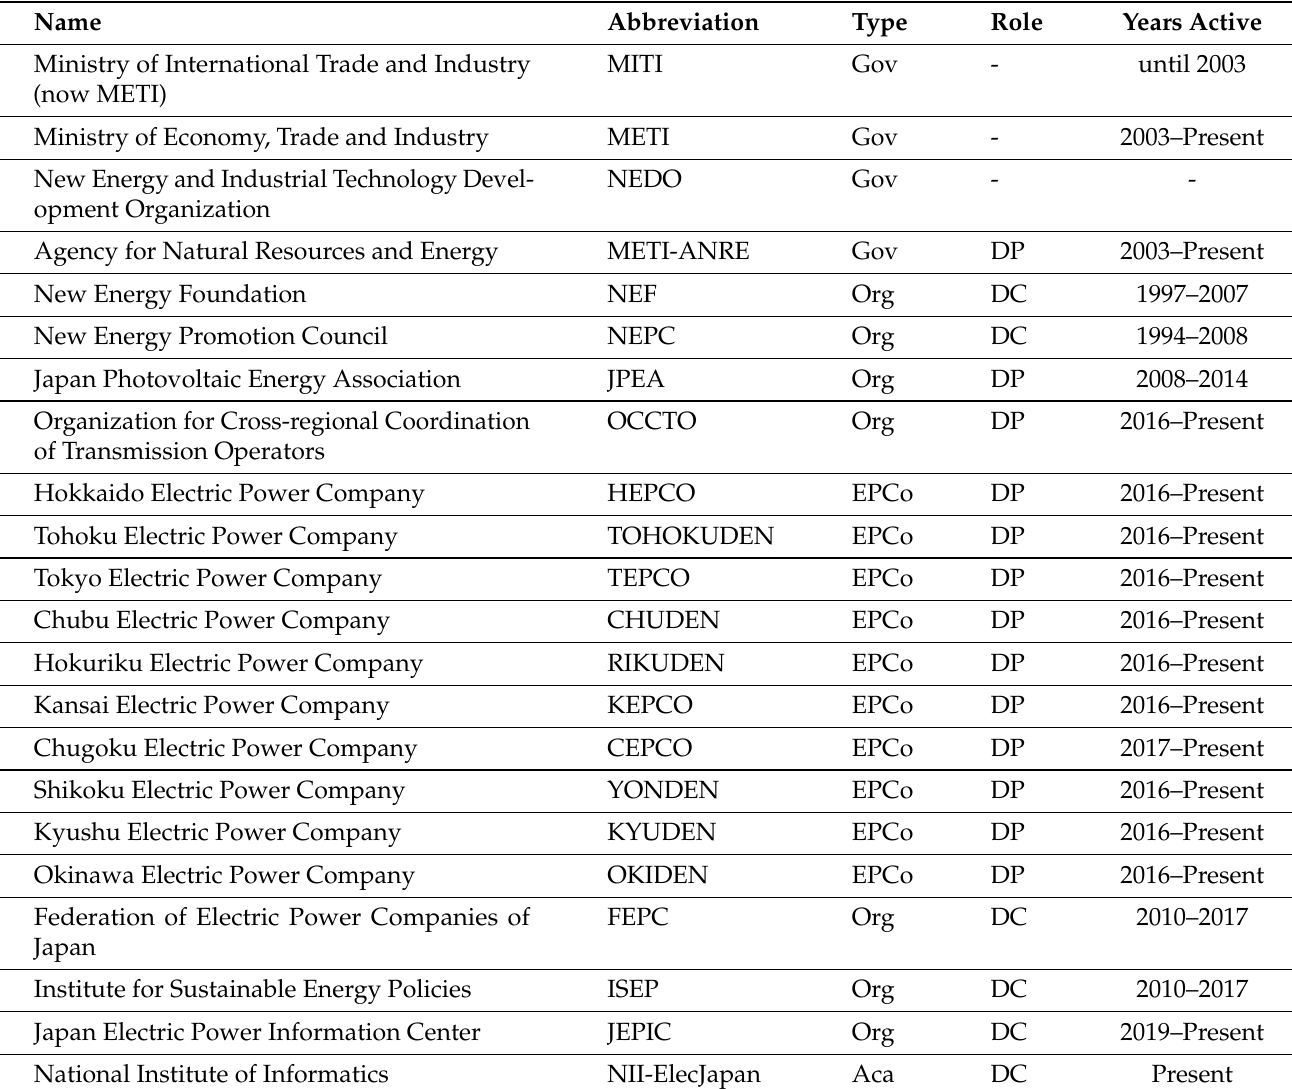
Table 1. Entities related to energy generation and data collection.